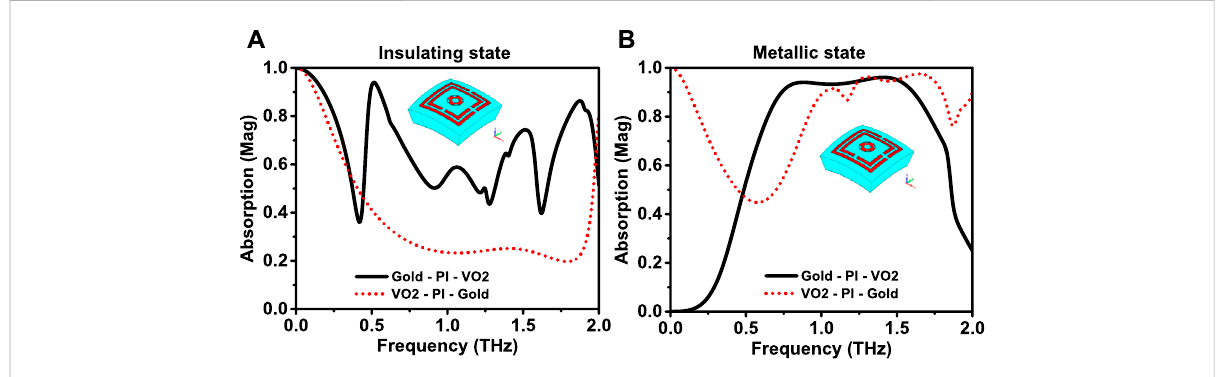
FIGURE 11 (A) Simulated results of absorption spectrum of Gold-PI-VO2 and VO2-PI-Gold structures when VO2 is in the insulating state and (B) in the metallic state (the whole structure is conformal).